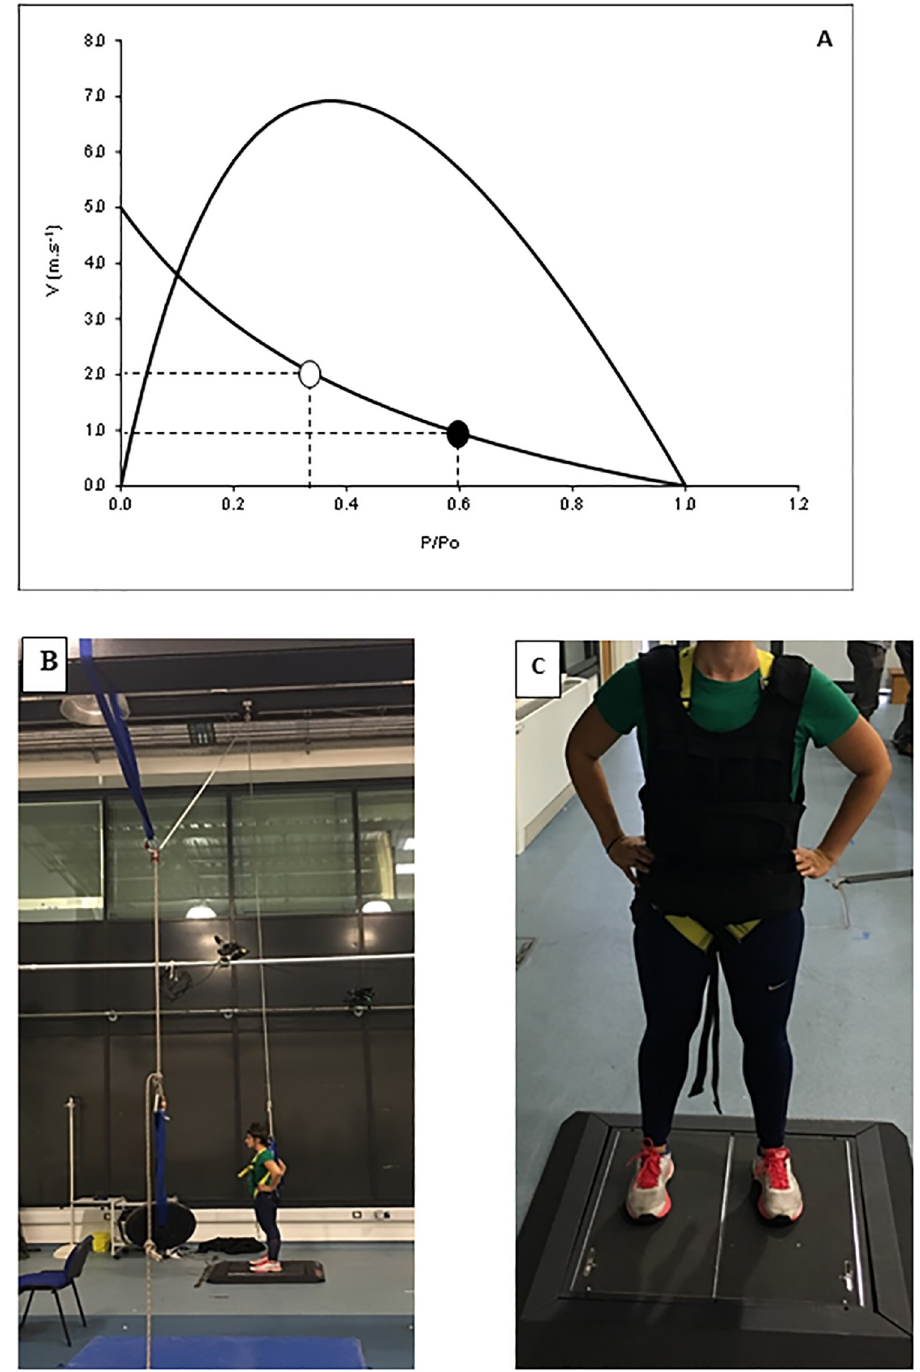
Fig 1. A) Force-velocity relationship illustrating that a higher body weight as a proportion of the maximal isometric force (P/Po) in an older (open symbol) than a young-adult person (closed symbol) results in a slower take-off velocity during a countermovement jump, even when the muscle contractile properties are unaltered. Participant set up for the B) unloaded condition, where a pulley system with counterweights was assembled. The other end of the rope was attached to the top of the harness of the participant enabling a 15% body weight (BW)-assisted jump and C) loaded condition, where 0.5-kg sandbags were added to a vest until 15% additional BW was acquired.